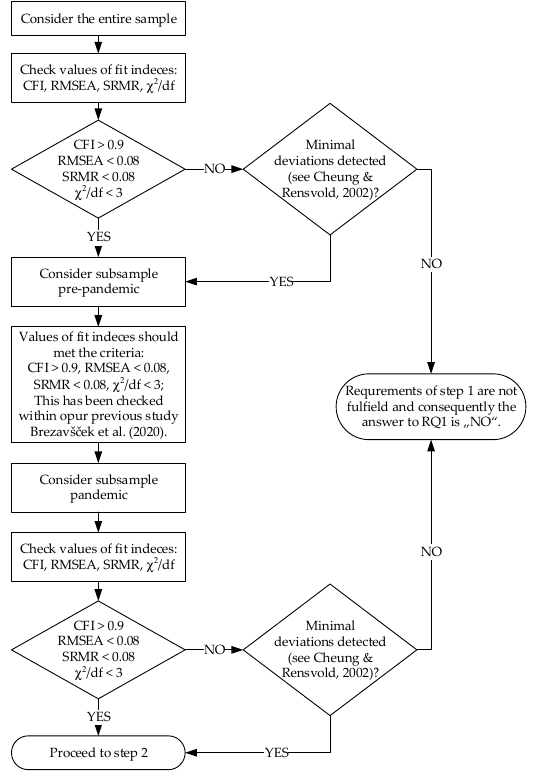
Figure 1. Step 1: Model overall fit evaluation [19,59].